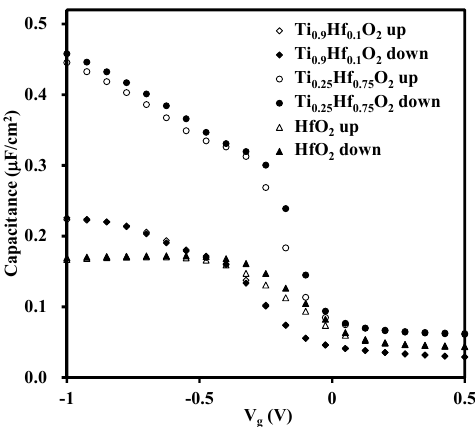
Figure 8. CV characteristics for the three samples of Ti 0.9 Hf 0.1 O 2 , Ti 0.25 Hf 0.75 O 2 , and HfO 2 . The gate voltage was swept from − 1 V to 0.5 V at a frequency of 1 MHz, and no horizontal shift is observed. For the CV characteristics of the Ti 0.25 Hf 0.75 O 2 sample, saturation in the accumulation region is not obtained regardless of the bias voltage level, which is attributed to the large leakage current observed in this sample.